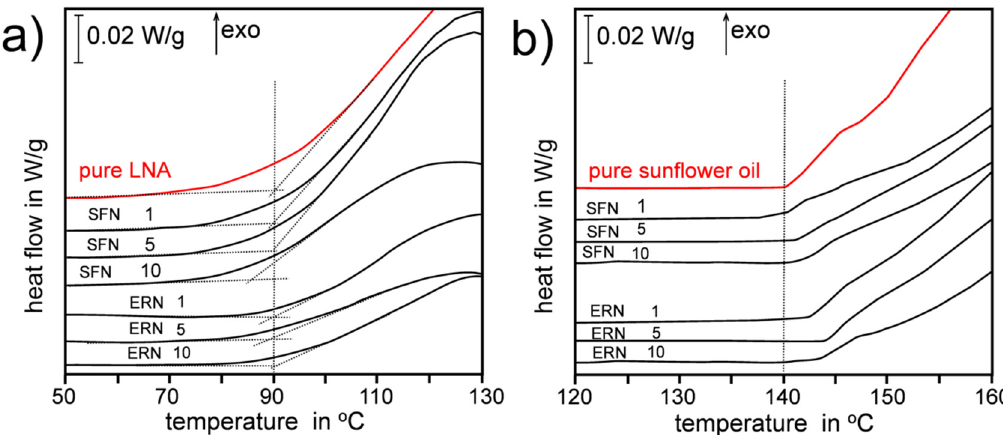
Figure 2. Thermal e ff ects of non-isothermal oxidation (heating rate β = 2.5 K / min) of pure linolenic acid (LNA) and LNA containing 1, 5 and 10 mM sulforaphane (SFN) / erucin (ERN) (panel a ). Thermal e ff ects of non-isothermal oxidation ( β = 2.0 K / min) of pure SUN and SUN containing 1, 5 and 10 mM SFN / ERN (panel b ). The DSC curves were vertically shifted for clarity. The number above each DSC curve denotes SFN / ERN concentration (in mM). Vertical dotted lines at 90 ◦ C and 140 ◦ C are introduced as a guide to the eye to observe a shift of temperatures of start of oxidation.